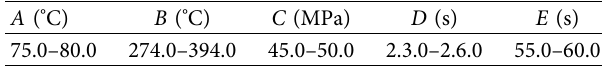
Table 11: Table of parameter